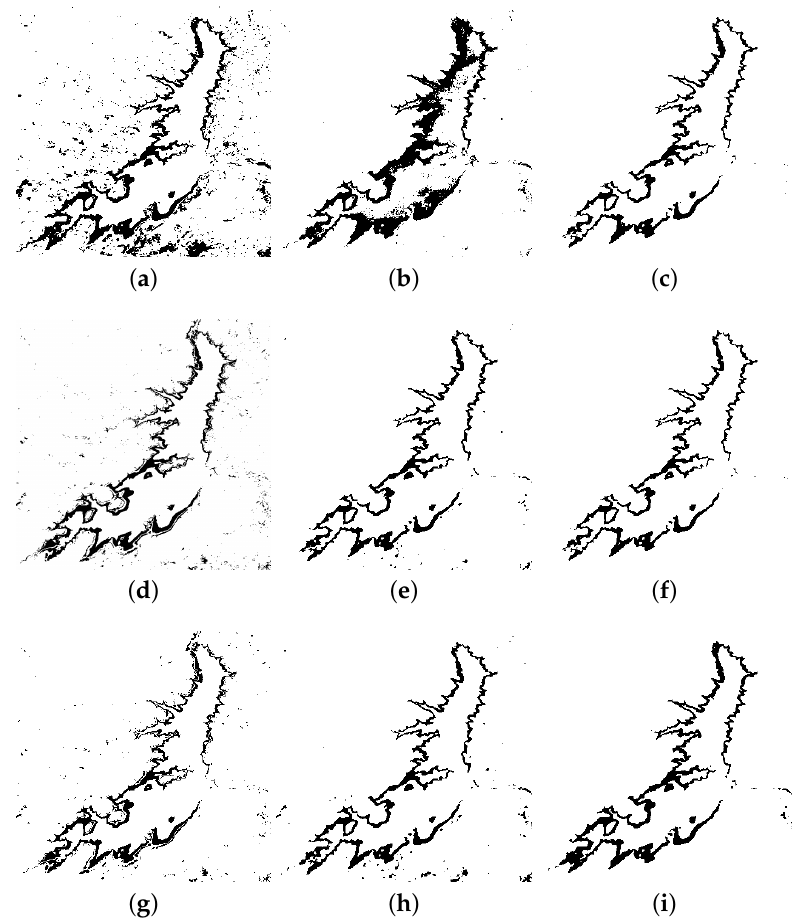
Figure 6. Change map of Itezhi Tezhi Dam, Zambia dataset (band 1) by ( a ) Normalized difference image (DI)+FCM ( b ) Ratio Image +FCM ( c ) Bandwise NSCT fusion +FCM ( d ) Bandwise NSCT fusion +SPSO ( e ) Bandwise NSCT fusion +PSOLF ( f ) Bandwise NSCT fusion +LIPSO ( g ) CVA ( h ) Transform change vector analysis (CVA)+LIPSO ( i ) Proposed NSCT feature fusion (All 4 bands)